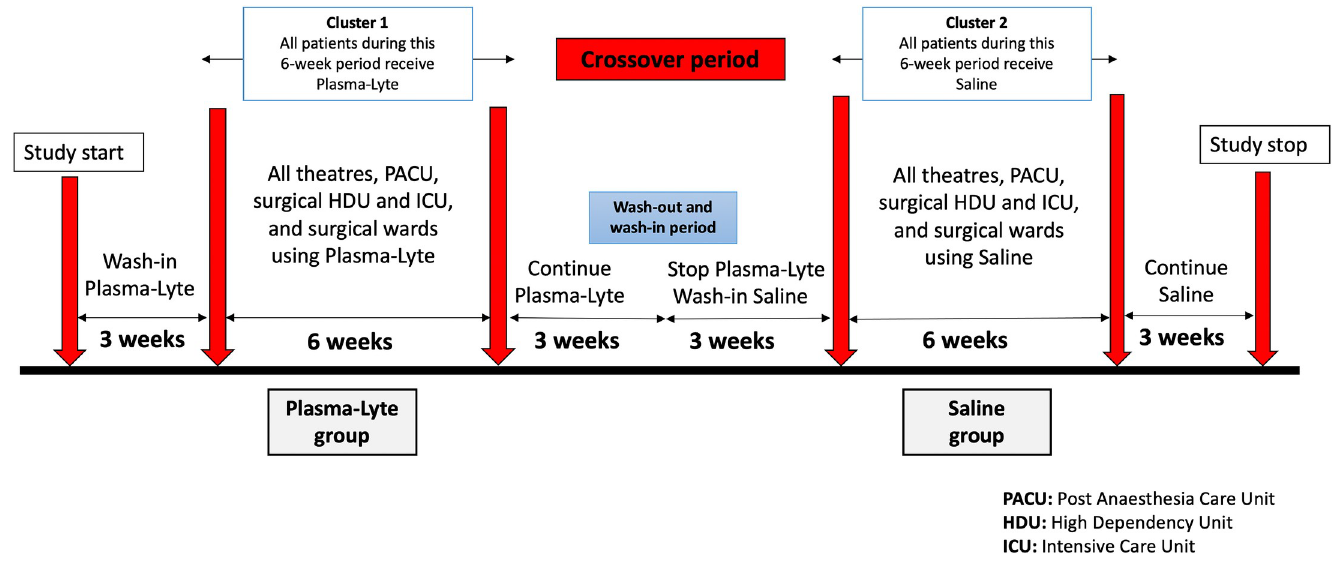
Fig 1. Cluster crossover design of Saline vs Plasma-Lyte